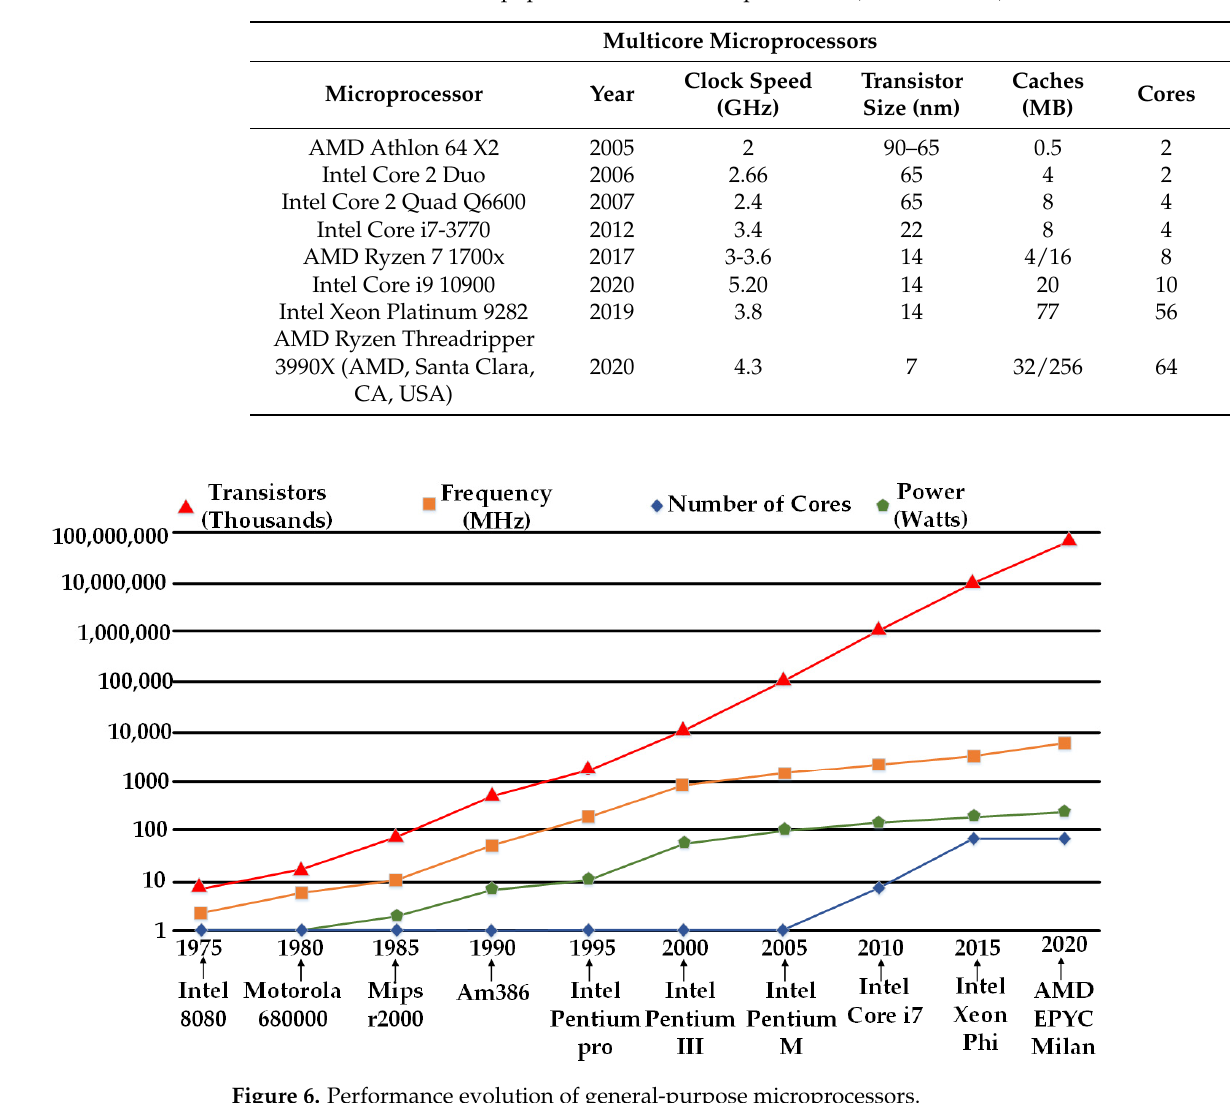
Figure 6. Performance evolution of general-purpose microprocessors.